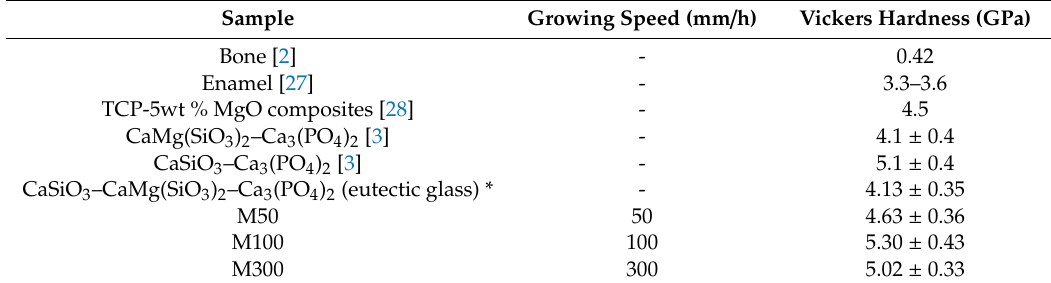
Table 6. Vickers hardness comparison of di ff erent materials used as bone substitutes. M50, M100, and M300 correspond to samples grown at 50, 100, and 300 mm /